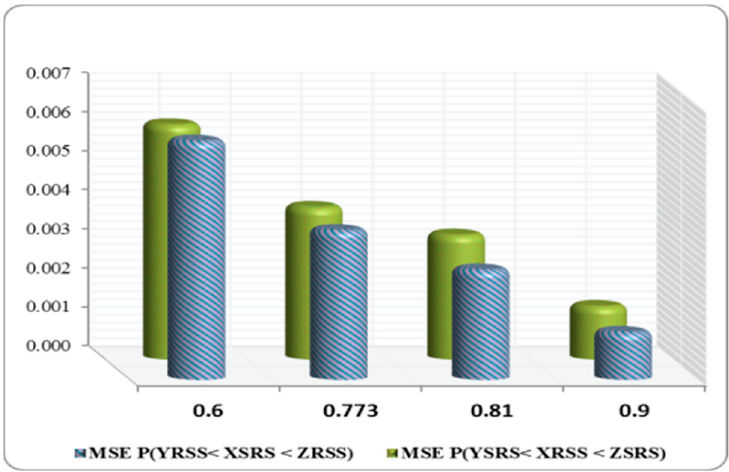
Figure 5. MSE of 3 ˆ and 4 ˆ for (n (cid:2870) , n (cid:2869)∗ , n (cid:2871) (cid:4667) = (2,20,2(cid:4667) at di ff erent values of .